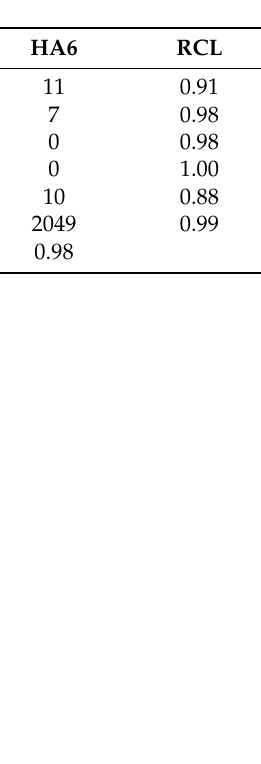
Table 4. Confusion matrix of model on WISDM dataset.